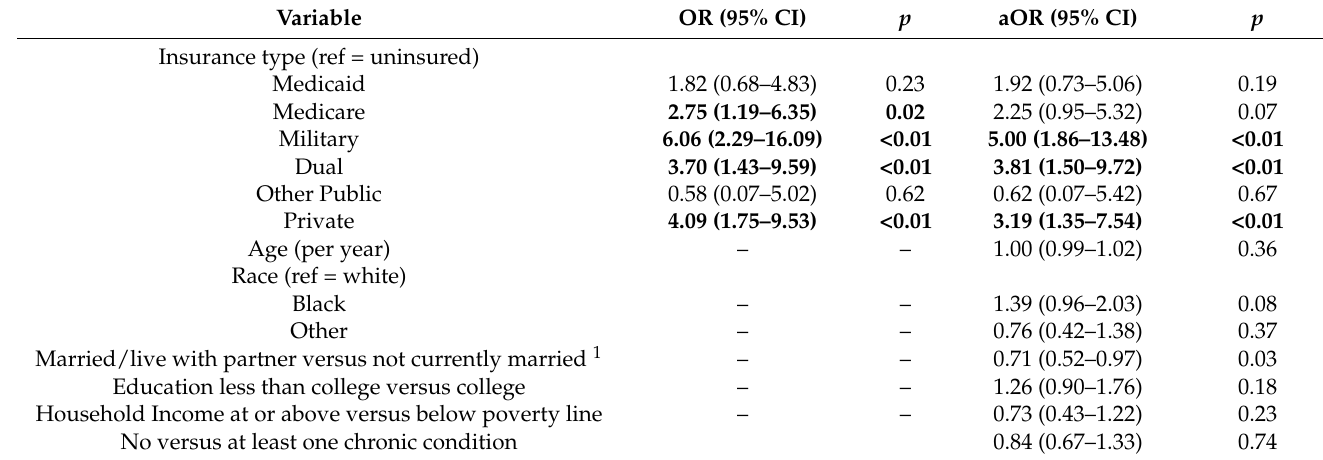
Table 3. Logistic regression evaluating association between the uptake of genetic testing/counseling for breast and/or ovarian cancer and health insurance type for at-risk